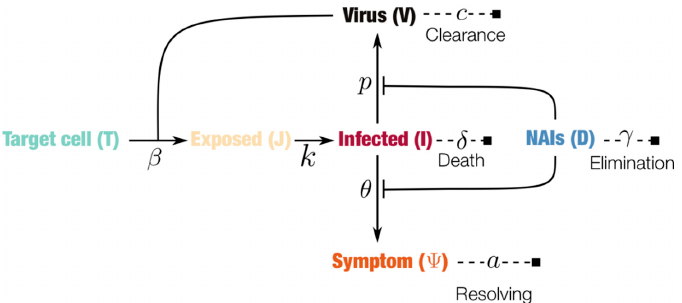
Figure 1. Schematic representation of the within-host influenza infection model under treatment with neuraminidase inhibitors (NAIs). Filled squares indicate endpoints, lines ending with bars indicate blocking effects and arrows indicate transitions, while dashed lines indicate the decay of the corresponding components. The system of equations and analyses are given in the Appendix A.